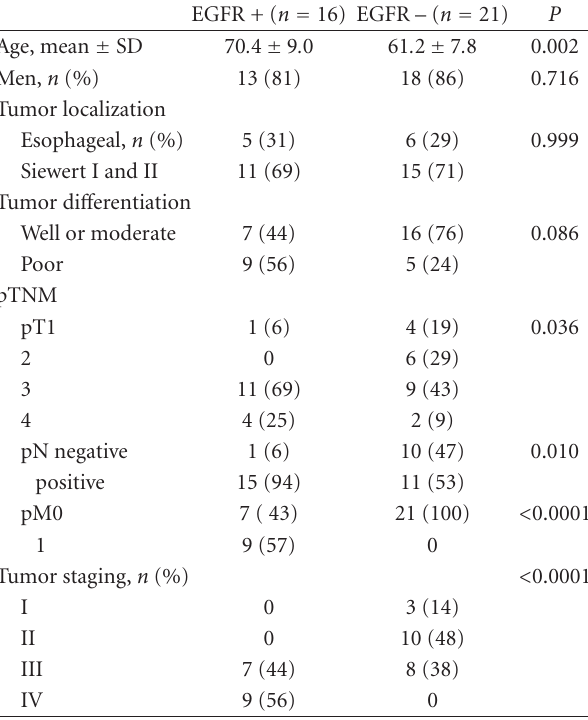
Table 1: Characteristics of patients with and without EGFR